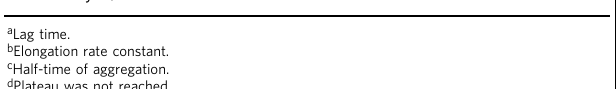
Table 1 Aggregation kinetics.